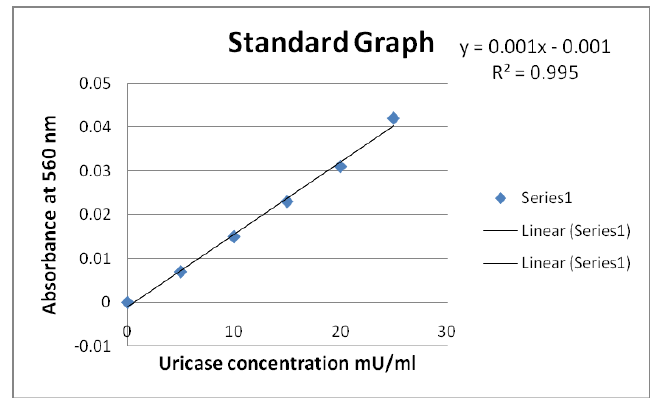
Figure 1. Standard graph for uricase estimation (1x reaction buffer pH